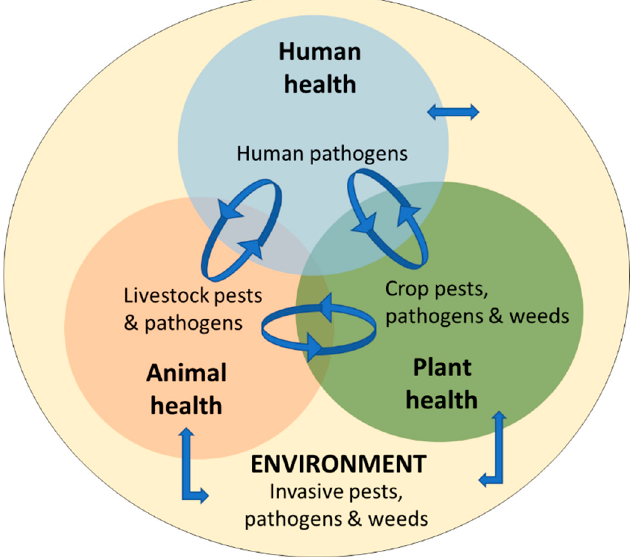
Figure 3. Schematic representation of the links among human, animal, plant, and environmental health (adapted from Hulme, 2020 [19]).